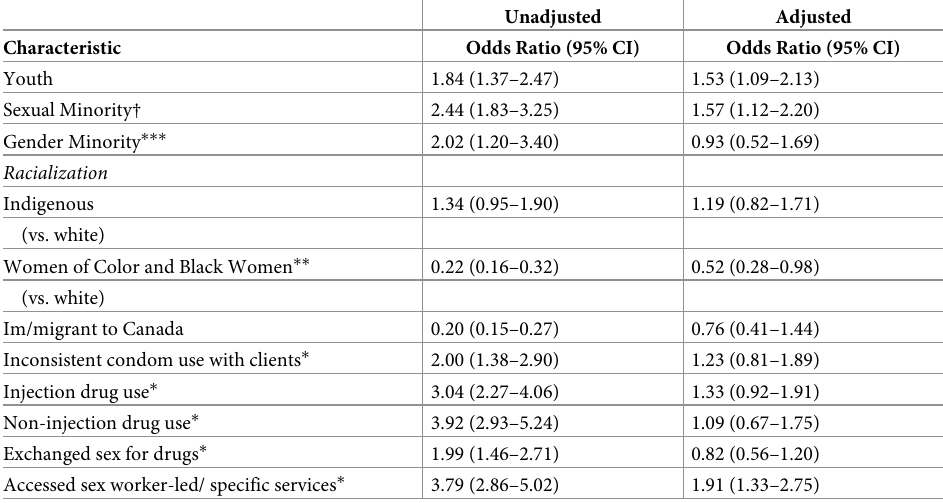
Table 2. Bivariate and multivariable analysis of factors correlated with recent STI/HIV testing (last 6 months) at enrollment among sex workers in Metro Vancouver, Canada (n = 897), AESHA